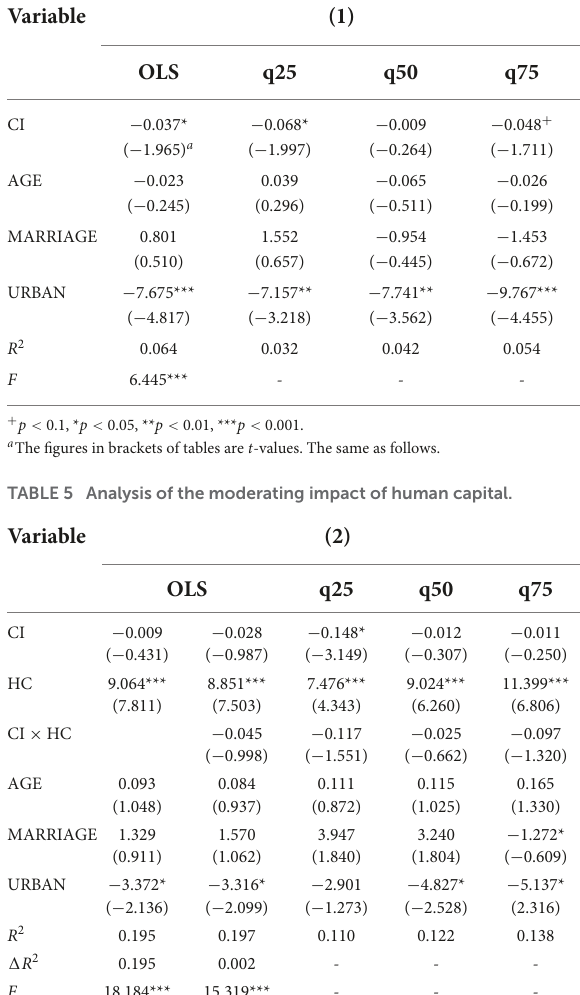
TABLE 4 Female career interruption and social integration.